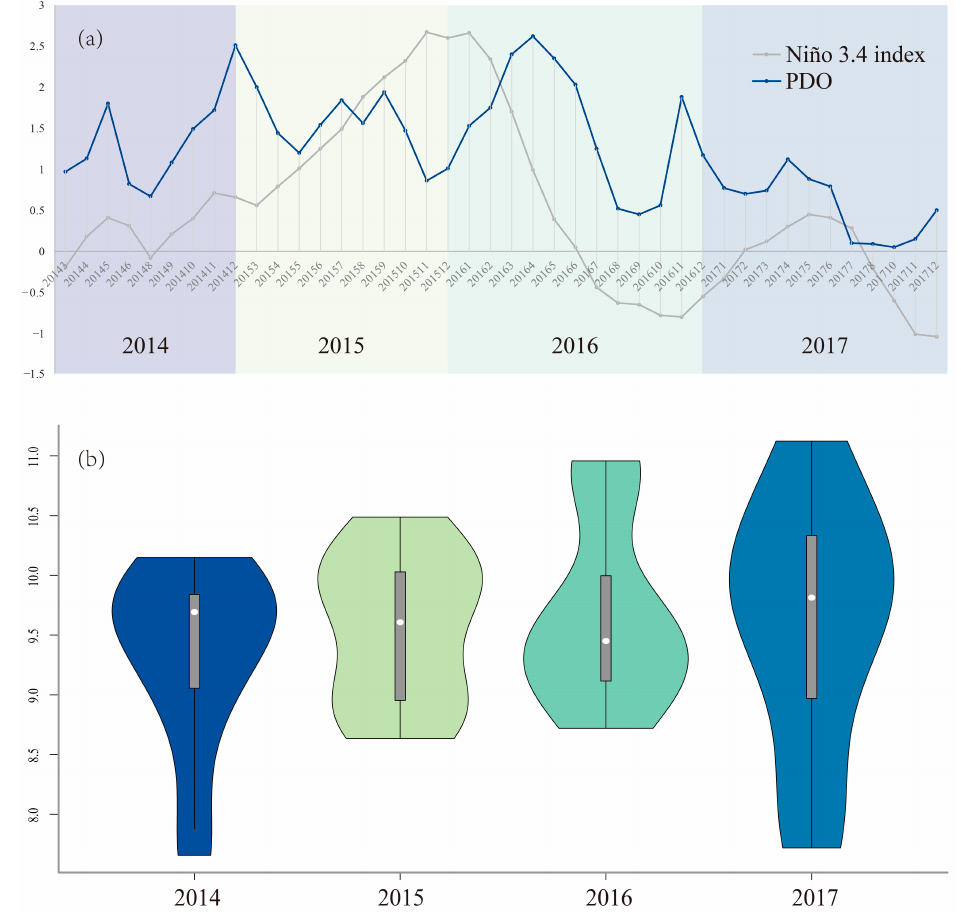
Figure 8. ( a ) Monthly Niño 3.4 index and PDO index for 2014–2017. ( b ) Latitudinal distribution range of monthly centers of gravity for 2014–2017.